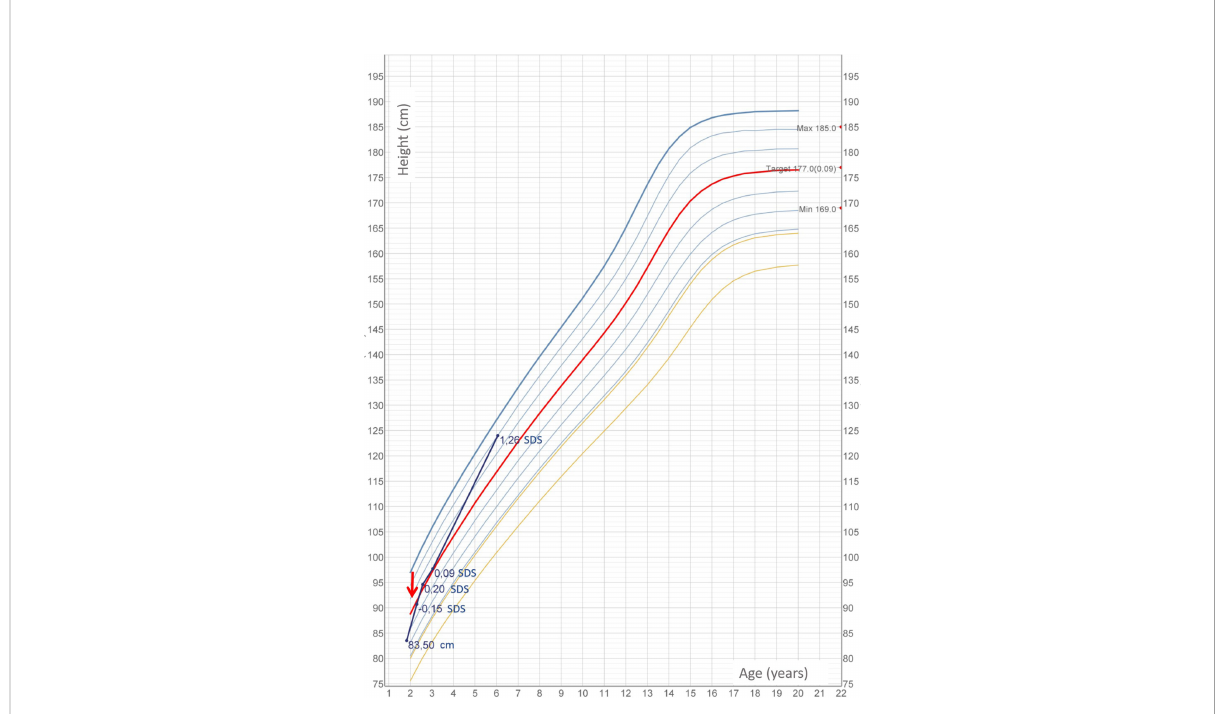
FIGURE 2 Child ’ s height measurements according to Cacciari growth chart 2006 for Italian population. Red arrow marks beginning of euthyroid